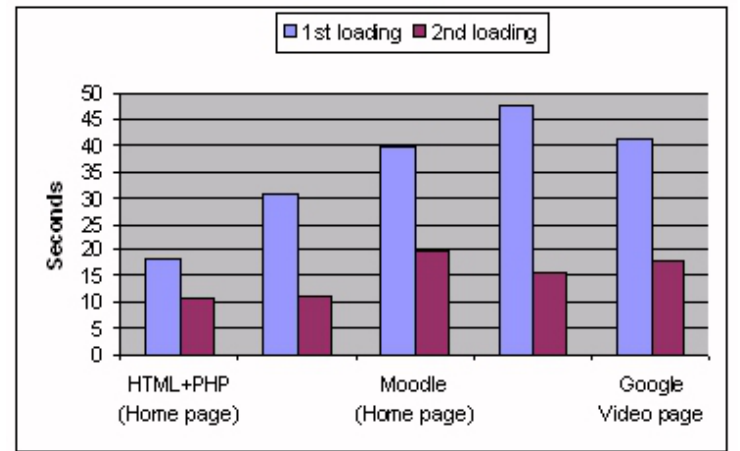
Figure 2. Browser loading speeds (Study A)